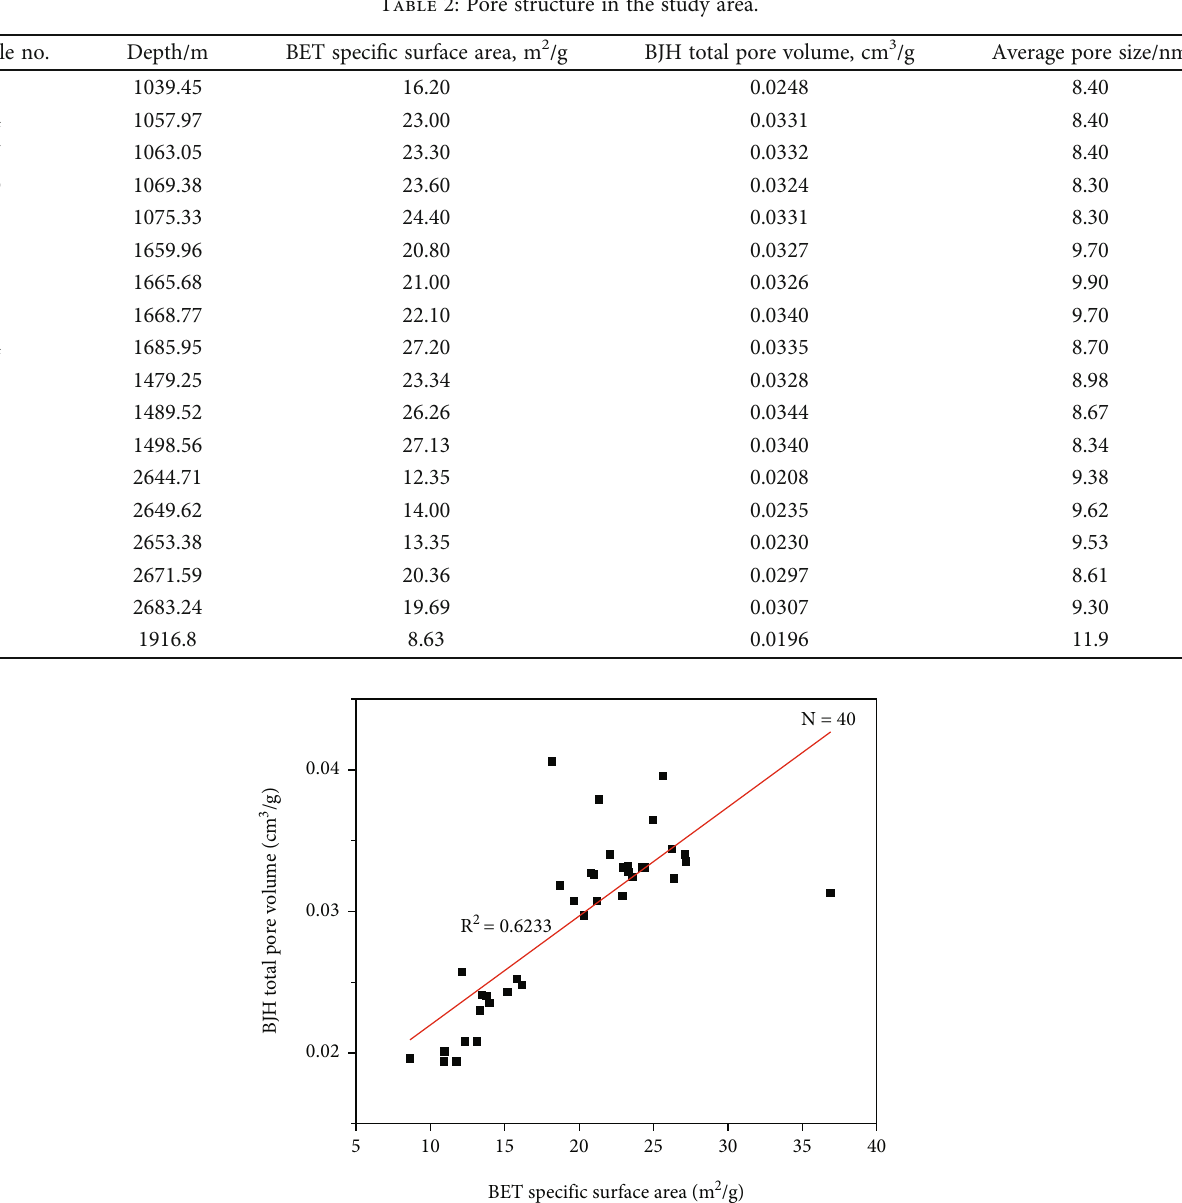
Table 2: Pore structure in the study area.